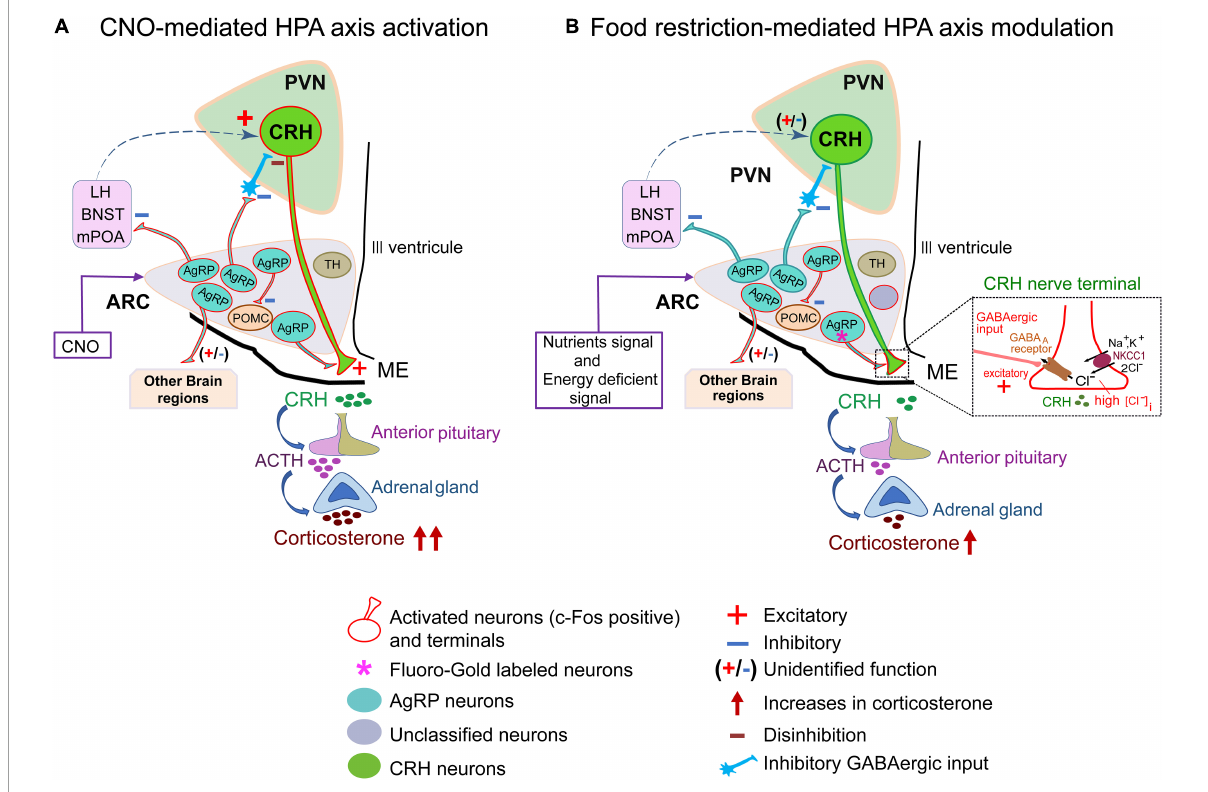
FIGURE6 Hypothetical model of hypothalamic-pituitary-adrenal axis activation by food restriction. (A) Schematic diagram of CNO-mediated HPA-axis activation. Agouti-related peptide (AgRP) neurons project to diverse brain regions such as the PVN, BNST, LH, mPOA and some other regions. CNO activates almost all subsets of AgRP neurons (91.1% ± 2%; Figure 2B ) in ARC to affect their downstream projecting neurons. As a result, about half of corticotropin-releasing hormone (CRH) neurons in the PVN (45.6% ± 1.9%; Figure 2E ) were activated and serum corticosterone levels were increased (326.5 ± 21.1 ng/ml; Figure 2C ). Dashed arrow line (blue) indicates proposed pathways of CRH neuronal activation. (B) Schematic diagram of food-restricted model: a subset of AgRP neurons in arcuate nucleus (ARC) (about 30%, Figure 4C ) directly project to the ME. About half (51.3% ± 1.7%) of AgRP neurons are activated by FR ( Figure 3F ). Among them, about 70% of ME-projecting AgRP neurons were activated by FR ( Figure 4E ), exhibiting excitation of CRH terminals to increase CRH release and serum corticosterone